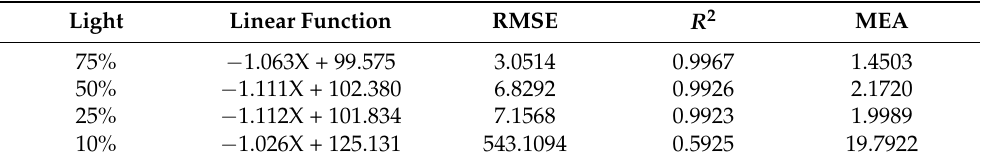
Table 11. The effect of ambient light on the performance; the results are presented for an urban location, from an altitude of 100 m, under various lighting conditions (ranging from 75 to 10% light). Light Linear Function RMSE R 2 MEA 75% − 0.485X + 96.490 − 0.486X + 95.730